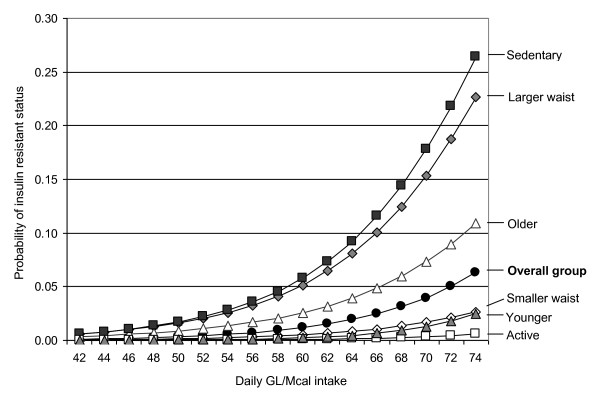
Predictive model of insulin resistance in LAW study women (n = 329) at differing intakes of GL per megacalorie (GL/Mcal). The predictive model uses average values in subgroups of women who were younger (≤ 61 years) or older (>61 years), sedentary (exercise frequency <2/week) or active (exercise frequency ≥ 2/week), and with smaller waist circumference (≤ 88 cm) or larger waist circumference (>88 cm), in comparison with the overall group (n = 329). Variables for the models are based on mean subject values, with an age of 61.7 years, waist circumference of 83.7 cm, physical activity level classification of active, and energy intake of 2.01 Mcal.